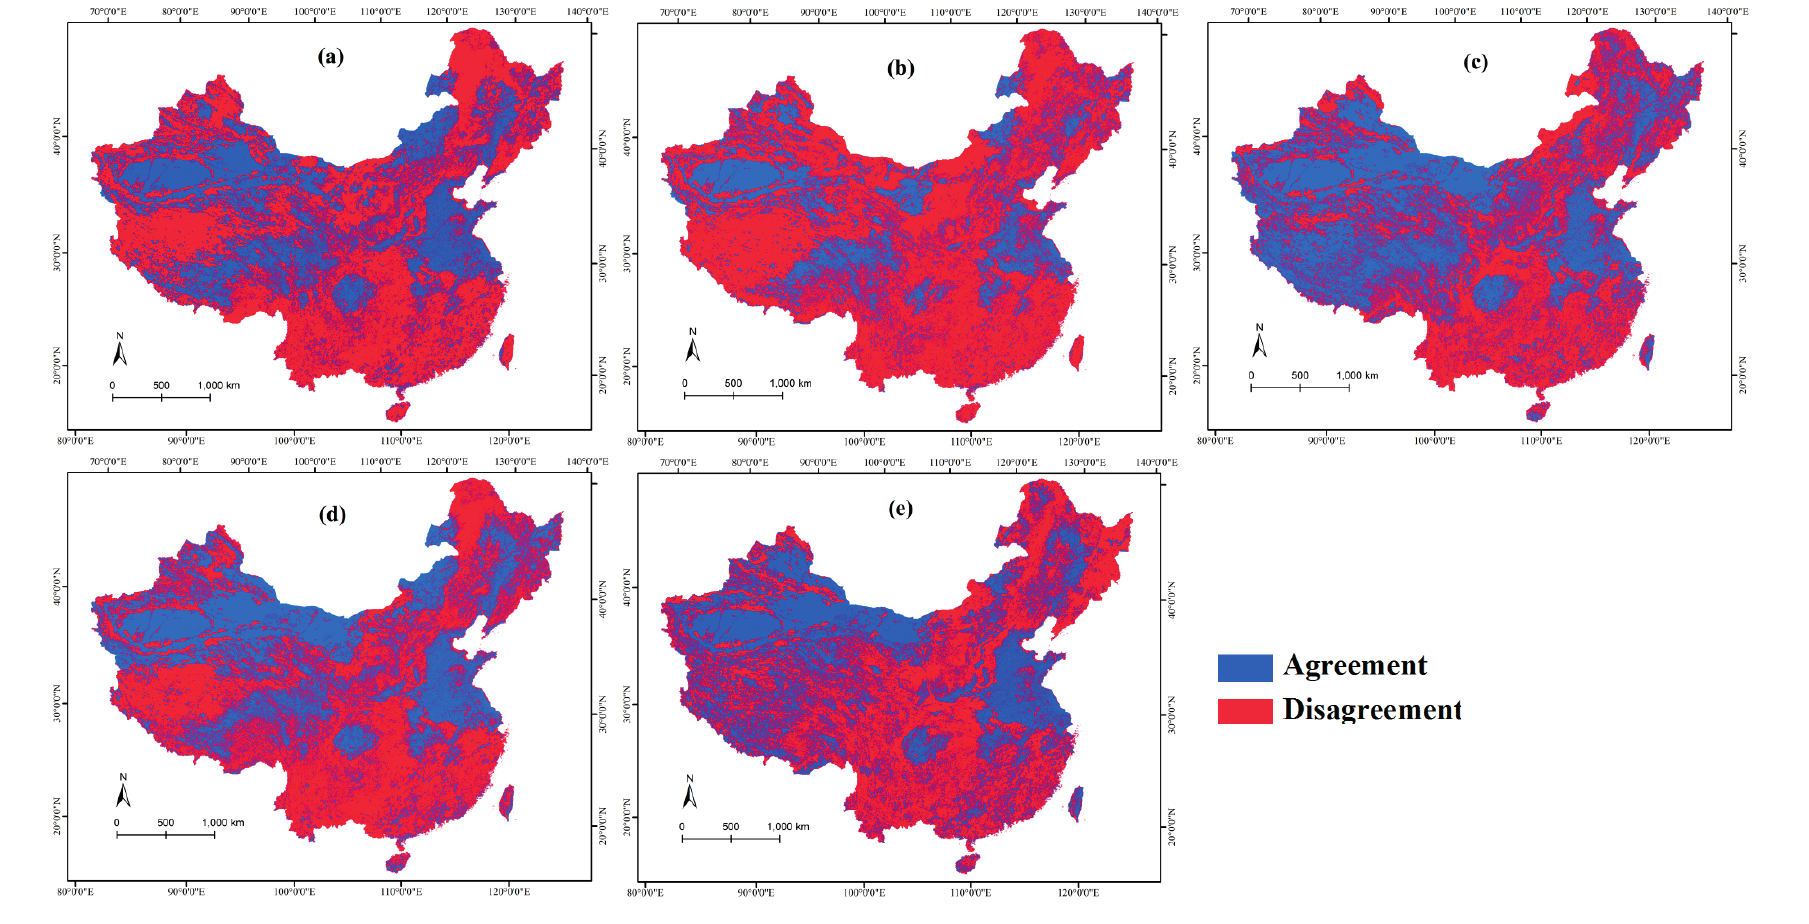
Figure 5. Spatial comparison of aggregated land cover classes between: ( a ) GLCC and GLCD-2005, ( b ) UMd and GLCD-2005, ( c ) GLC2000 and GLCD-2005, ( d ) MODIS LC and GLCD-2005, and ( e ) GlobCover and GLCD-2005,